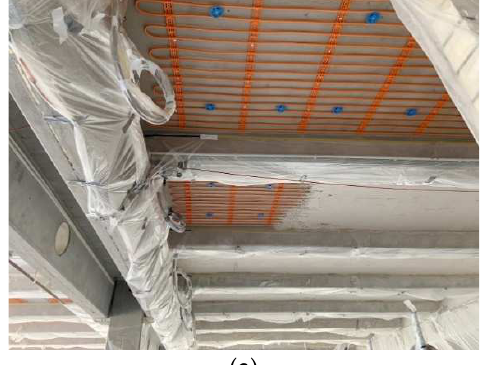
( b ) Figure 4. Measurement concept demonstrator for the 5th floor ( a ) and the 2nd floor ( b ). The operational room temperature is determined by measuring the air temperature with PT100 sensors and the radiation temperature with a globe thermometer. The vertical air temperature difference is measured in the centre of the room using PT100 sensors at heights of 0.1 m, 1.3 m and 2.8 m above the floor. Air temperature meas- urements are conducted at different power outputs of the heat transfer systems. These occur due to different outdoor temperatures or depending on the different room temper- ature setpoints. Monovalent operation (without radiators) was always selected when ob- serving the influence of the surface heating system in isolation. The measurement results are only determined for steady-state conditions since during strong changes in perfor- mance the air temperature differences are also subject to high dynamics.